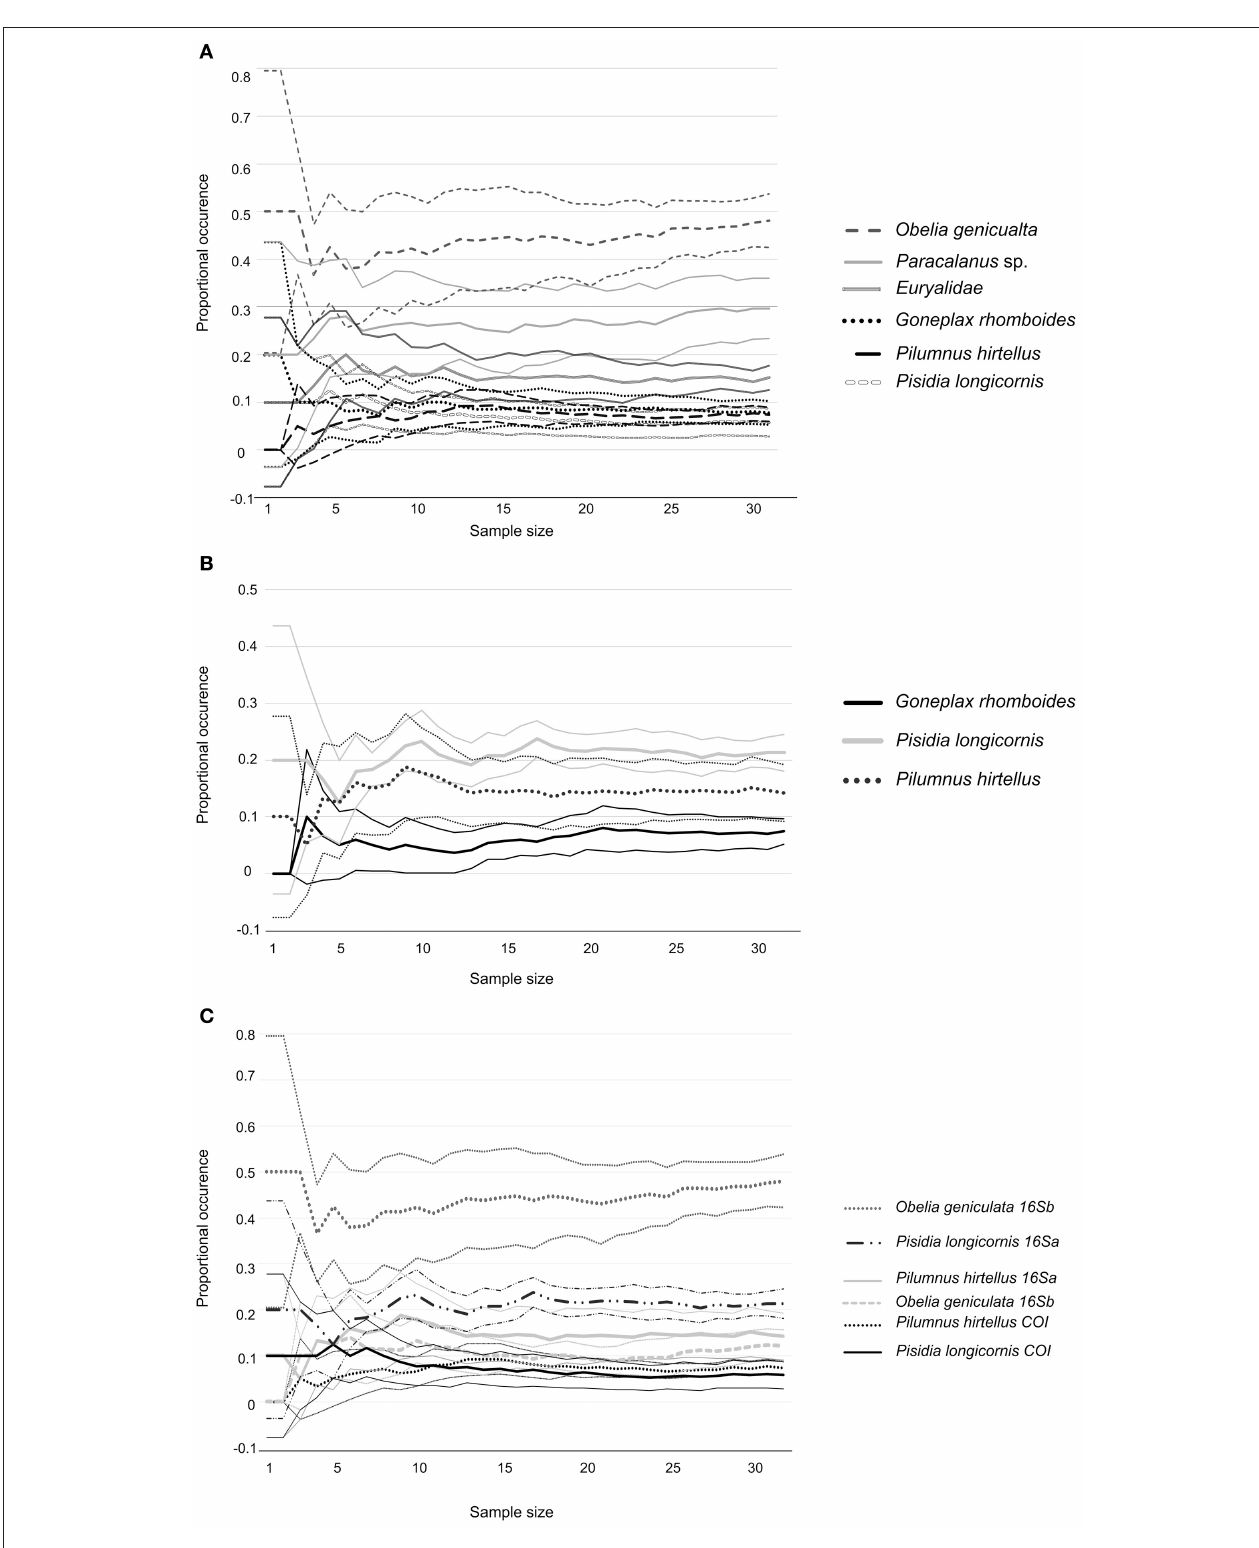
FIGURE 9 | Summary from 10 randomized sample sets of species identified in A. media with primers COI (A), primers 16Sa (B) , and both pair of primers (C) . Average values are presented as continues lines and Confidence Intervals (C.I.) as dashed lines.